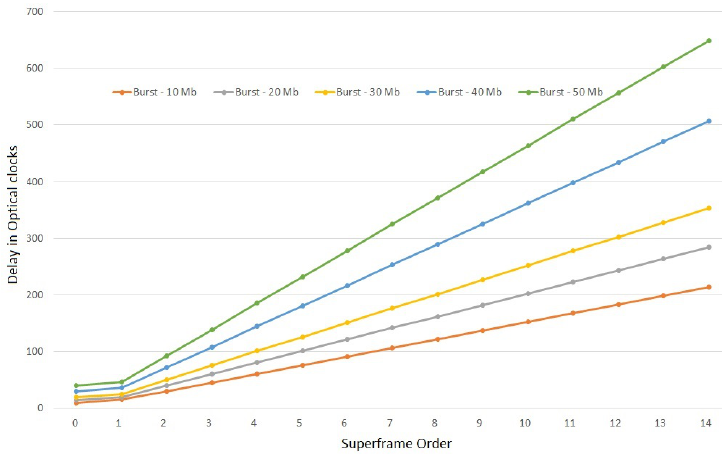
Figure 10. Delay bound (optical